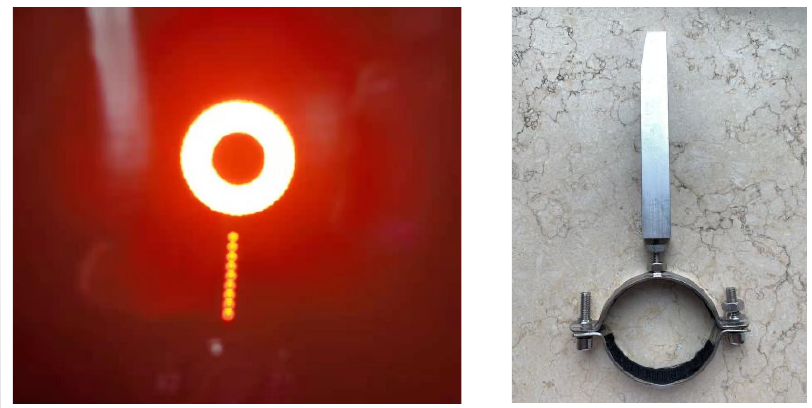
Figure 14. Design of the optical target and the bracket.